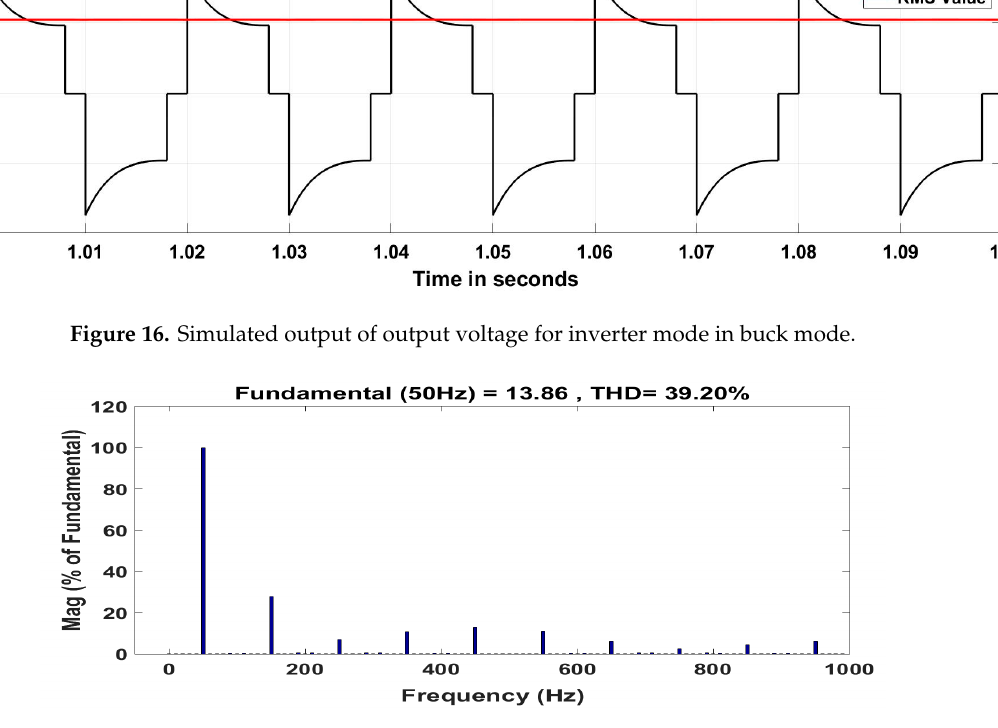
Figure 17. Simulated Fast Fourier Transform (FFT) analysis of buck inverter output with Total Harmonic Distortion (THD).